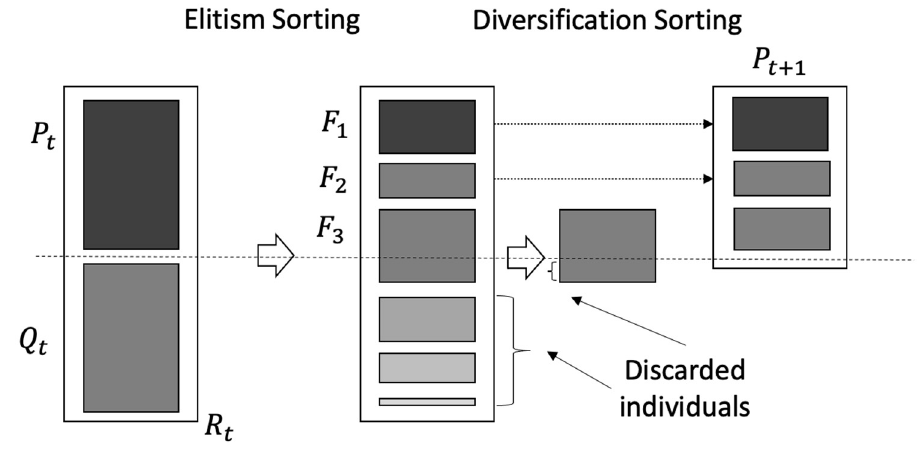
Figure 4. Elitism sorting and diversification phases.